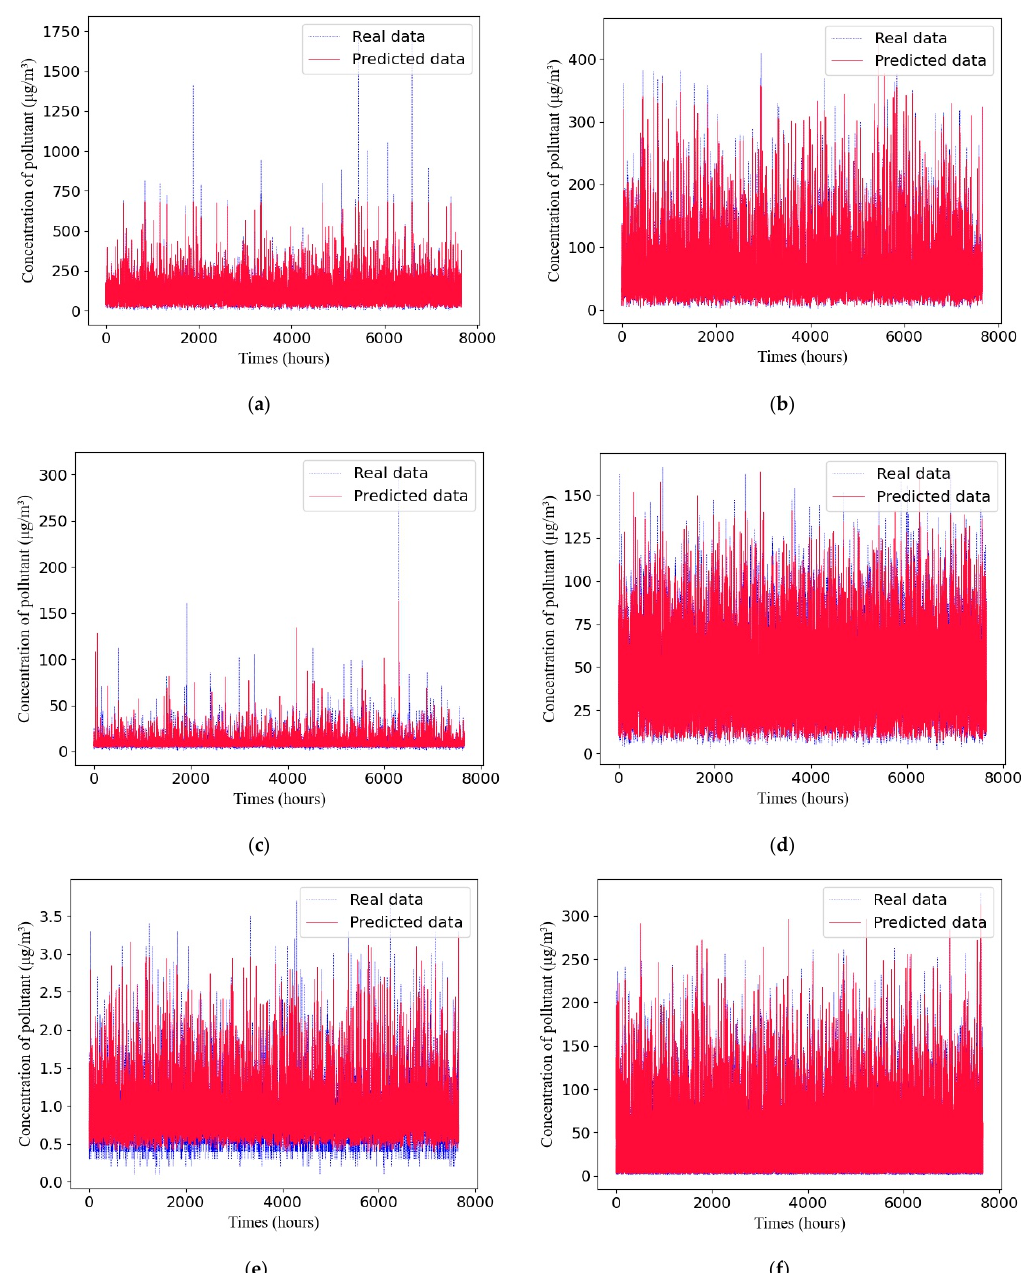
Figure 7. Comparison of the predicted values and real values of different pollutants with the GRU network in Dataset 1: ( a ) PM 10 ; ( b ) PM 2.5 ; ( c ) SO 2 ; ( d ) NO 2 ; ( e ) CO; ( f ) O 3 . The air-quality-prediction results of SVM, RNN, LSTM, and GRU_GA for Dataset 2 are shown in Table 14. Table 14. The prediction results of GRU_GA compared with other air-quality-prediction methods with Dataset 2.